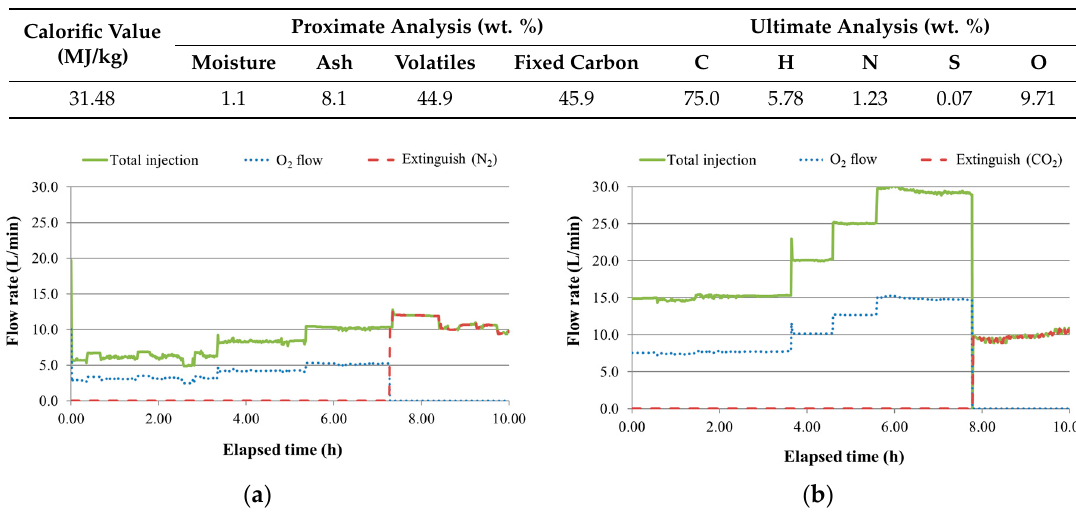
Figure 4. Gasification agents during experiments: ( a ) Experiment 1; ( b ) Experiment 2.